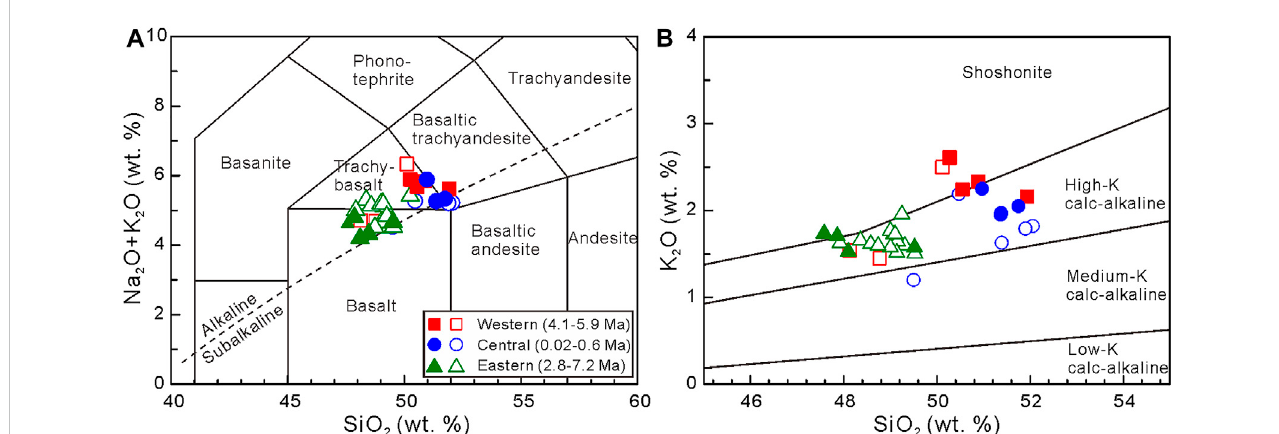
FIGURE 3 Cross-plotsof (A) Na 2 O+K 2 O(wt.%)versusSiO 2 (wt.%).Theclassi fi cationboundariesarefromLeBasetal.(1986)andLeMaitreetal.(1986). (B) K 2 O(wt.%) versus SiO 2 (wt.%) diagram for the Tengchong basalts. The boundaries are from Peccerillo and Taylor (1976) and Rickwood (1989). The fi lled symbols denote data from thisstudy, and theopen symbolsare from theliterature (Zhang etal., 2012; Zou etal., 2017;Cheng etal., 2018;Tian etal., 2018;Cheng et